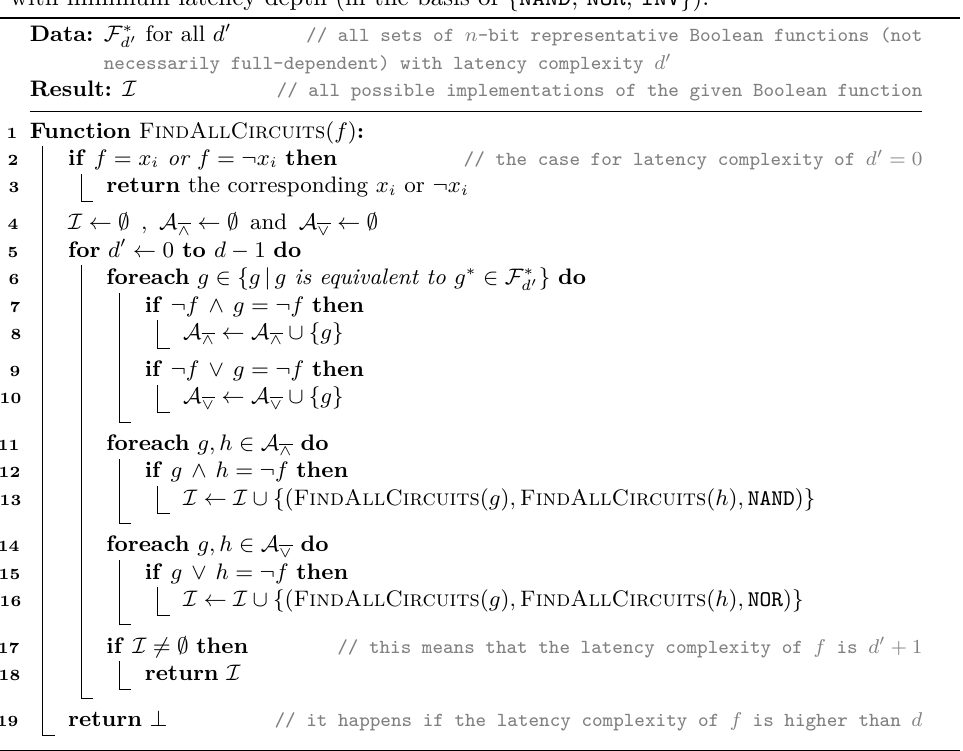
Algorithm 2: Finding all possible implementations of an n -bit Boolean function with minimum latency depth (in the basis of { NAND , NOR , INV